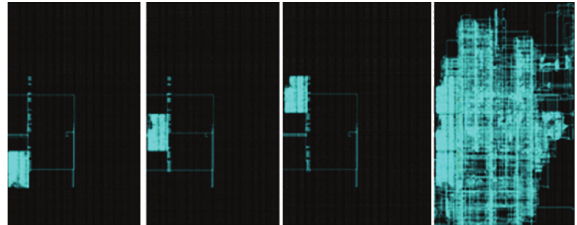
Figure 6: FE1, FE2, FE3, and the complete circuit.